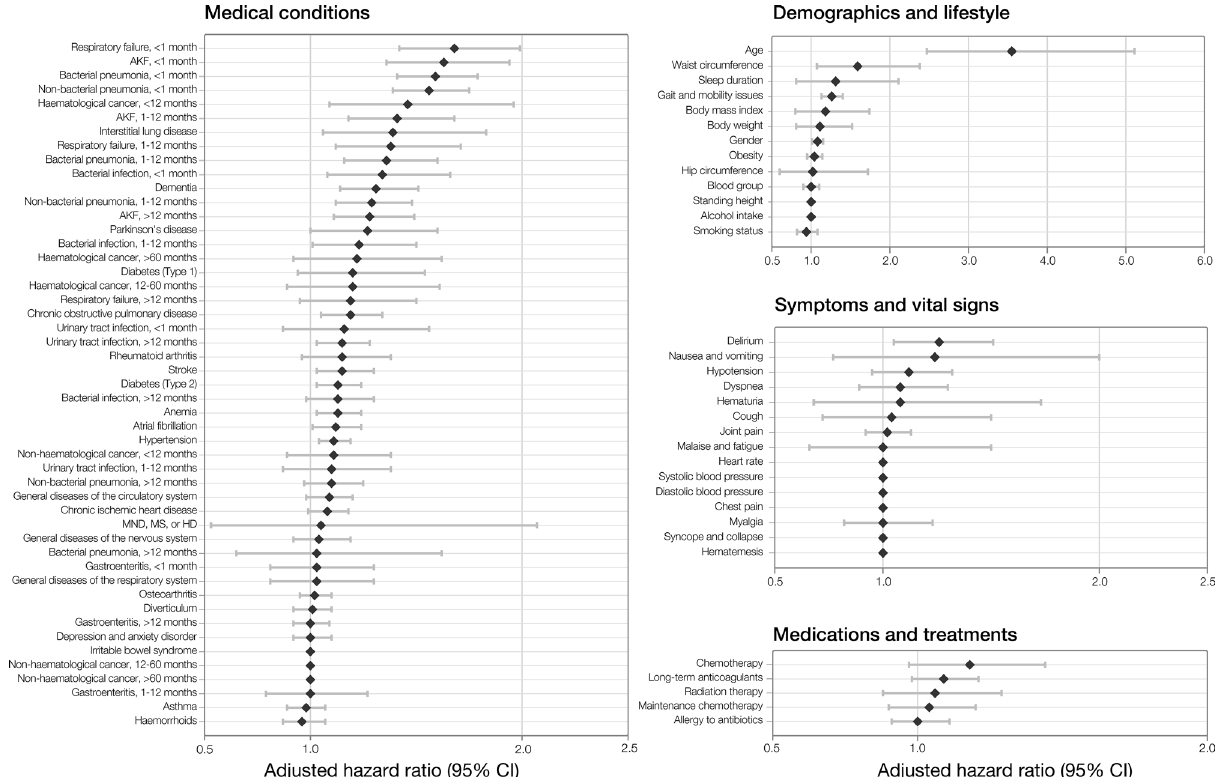
Figure 3. Plot of Cox model coefficients of COVID-19 mortality in UK Biobank cohort. Values show HR ± 95%CI. AKF = acute kidney failure, MND = motor neurone disease, MS = multiple sclerosis, HD = Huntington’s disease, HR = hazard ratio, CI = confidence